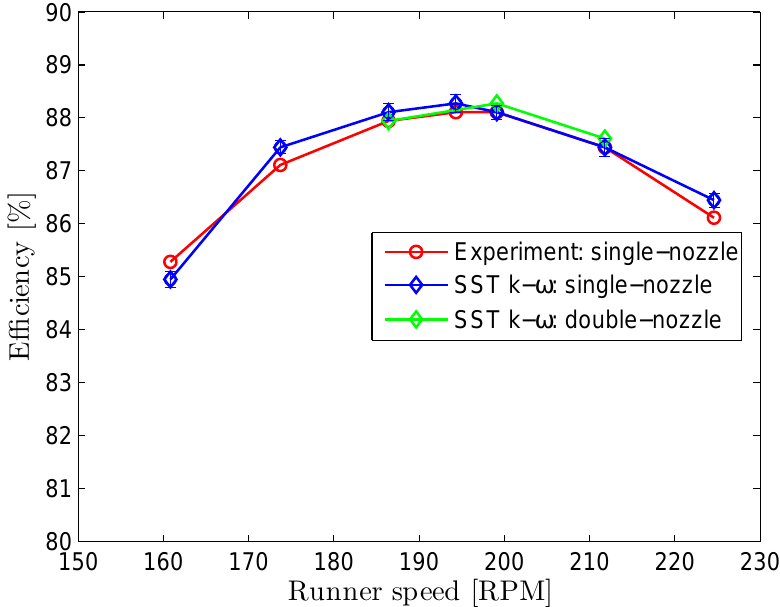
Figure 6. Comparison of single- and double-nozzle performance at Q max = 46 lps per nozzle and head H = 1.337